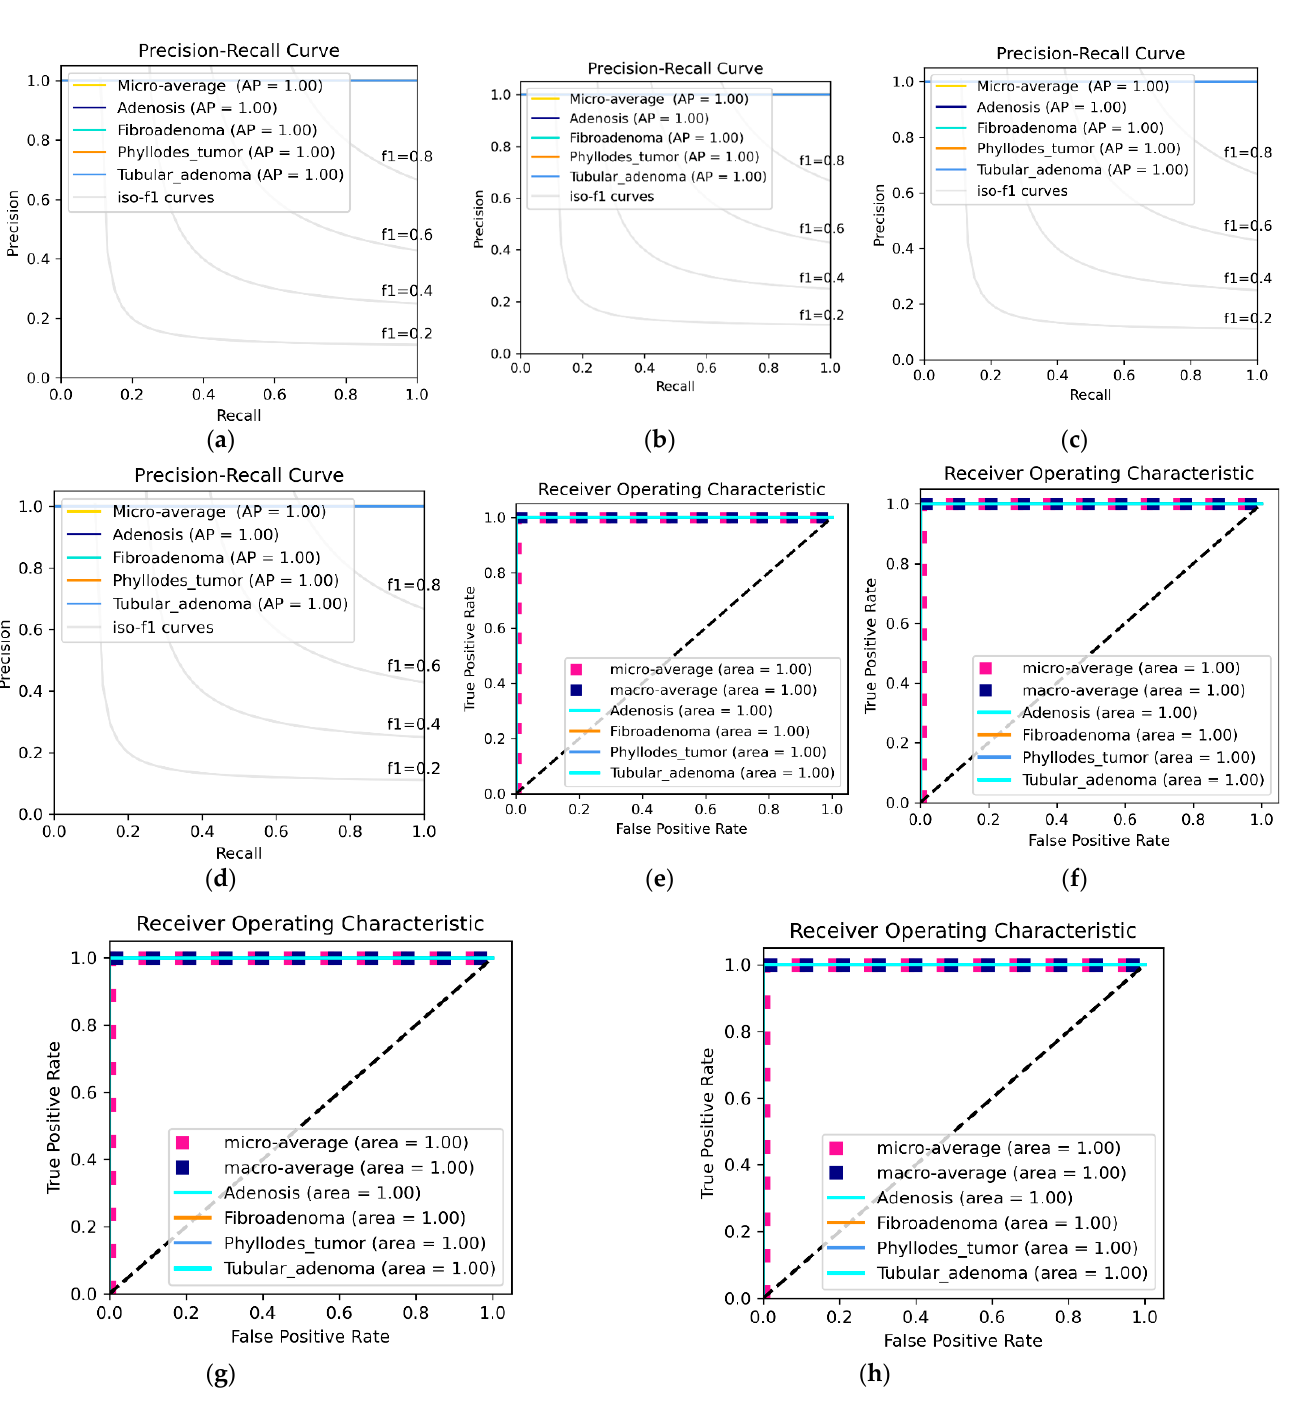
Figure 7. Benign individual class performance using Receiver Operating Characteristics (ROC) Curve and Precision–Recall (PR) Curve. ( a ) depicts the PR Curve @40×, ( b ) depicts PR Curve @100× ( c ) depicts PR Curve @ 200×, ( d ) depicts PR Curve @ 400×, ( e ) depicts ROC curve @ 40×, ( f ) depicts ROC curve @ 100×, ( g ) depicts ROC curve @ 200×, and ( h ) depicts ROC curve @ 400×.